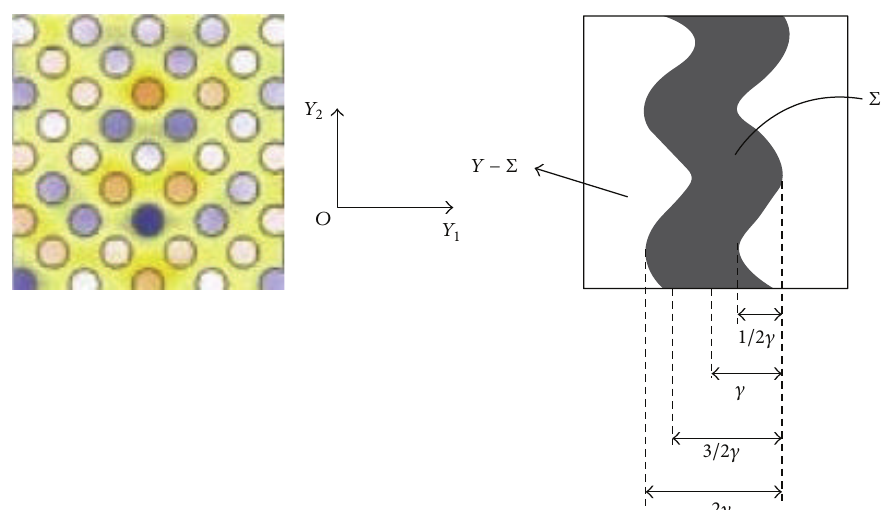
Figure 2: The representative cell 𝑌 ⊂ R 2 (cf. this figure with figure 1 in [3]).